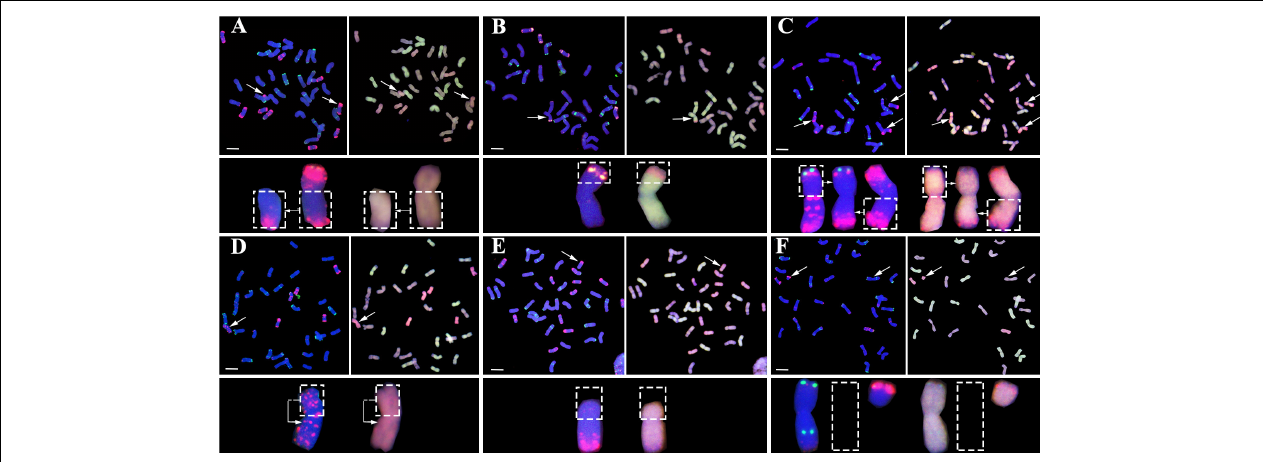
FIGURE 3 | Representative structural chromosome variations (SCVs) in the immediate progenies of the pentaploid wheat lines. (A) Telocentrics, (B) Inter-subgenome translocations, (C) Intra-subgenome translocations, (D) Isochromosomes, (E) Truncations, and (F) Telocentrics coupled with monosomic 2B (loss of one 2B chromosome). In (A) through (F) , the FISH images (left of each panel pair) are signals of pSc119.2 (green) and pAs1 (red), while the GISH images (right of each panel pair) are the signals of A subgenome (green), D subgenome (red), and B subgenome (blue), respectively. Structural variant chromosomes (marked by arrows) are zoomed in and shown below the images accordingly; while the dashed-lined empty frames in (F) refer to loss of one 2B chromosome (monosomic 2B). In all images, the bars = 10 µ m.